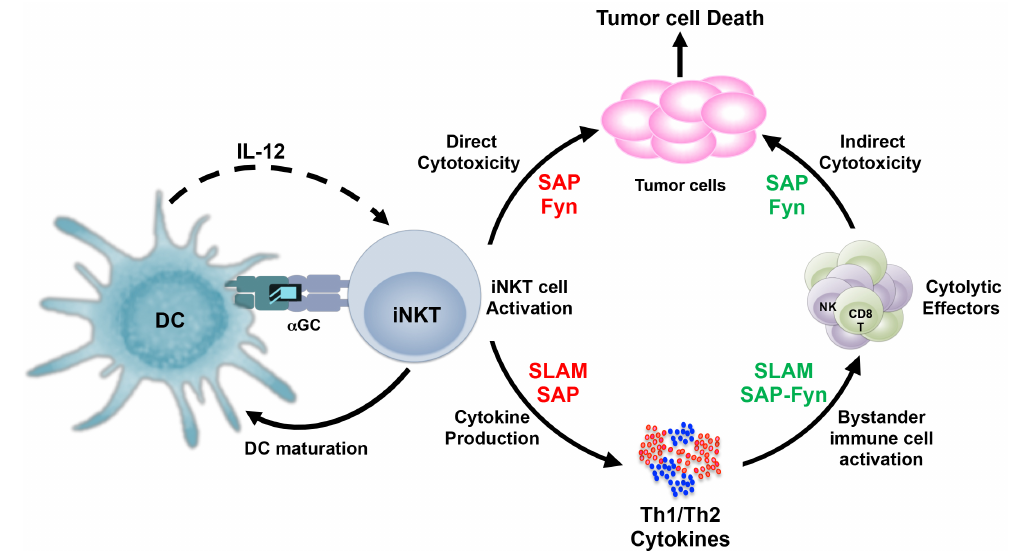
Figure 3. SLAM-SAP-Fyn regulate the antitumor mechanisms of iNKT cells. Invariant NKT cells recognize glycolipid antigens when presented by antigen presenting cells (such as DCs) and rapidly produce large amounts of Th1 and Th2 cytokines, which is dependent on SLAM family of receptors and may be SAP, in some cases. For direct cytotoxic response, iNKT cells critically rely on signals generated by SAP and the Fyn kinase, although their physical interaction with each other may not be necessary. Antigen-induced cytokine production by iNKT cells leads to activation of other immune cells, including CD8 + T and NK cells. These cytotoxic e ff ectors depend on the SLAM-SAP-Fyn axis for their cytokine production as well as cytolytic functions. Dependence on the SLAM-SAP-Fyn signals by iNKT cells and / or other immune cells (such as CD8 + T and NK cells) are indicated by red and green fonts